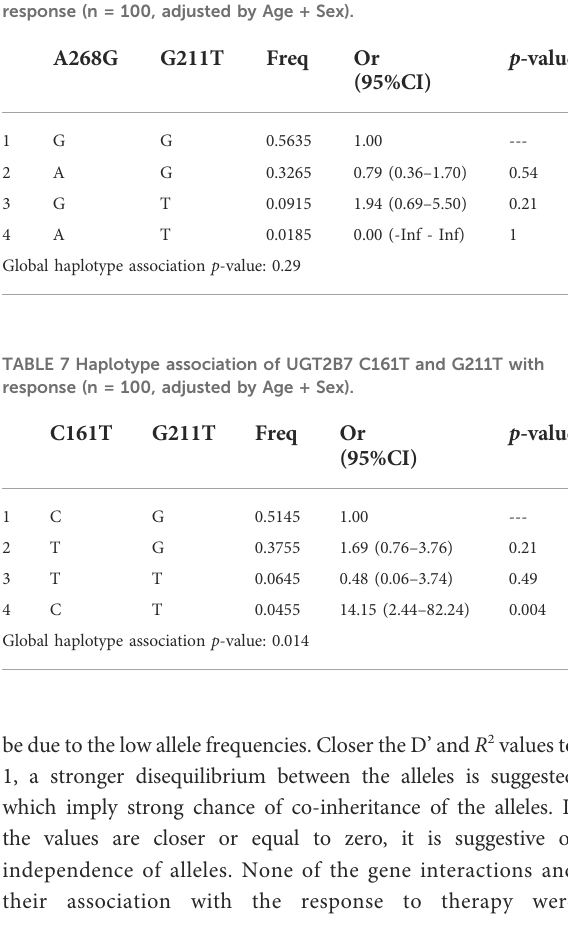
TABLE 6 Haplotype association of UGT2B7 A268G and G211T with response (n = 100, adjusted by Age + Sex).